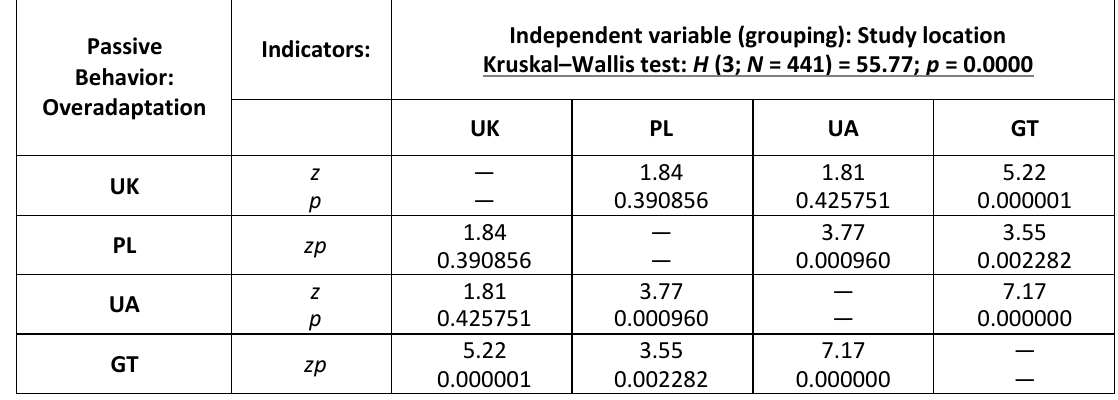
Table 6. Post-hoc tests for overadaptation